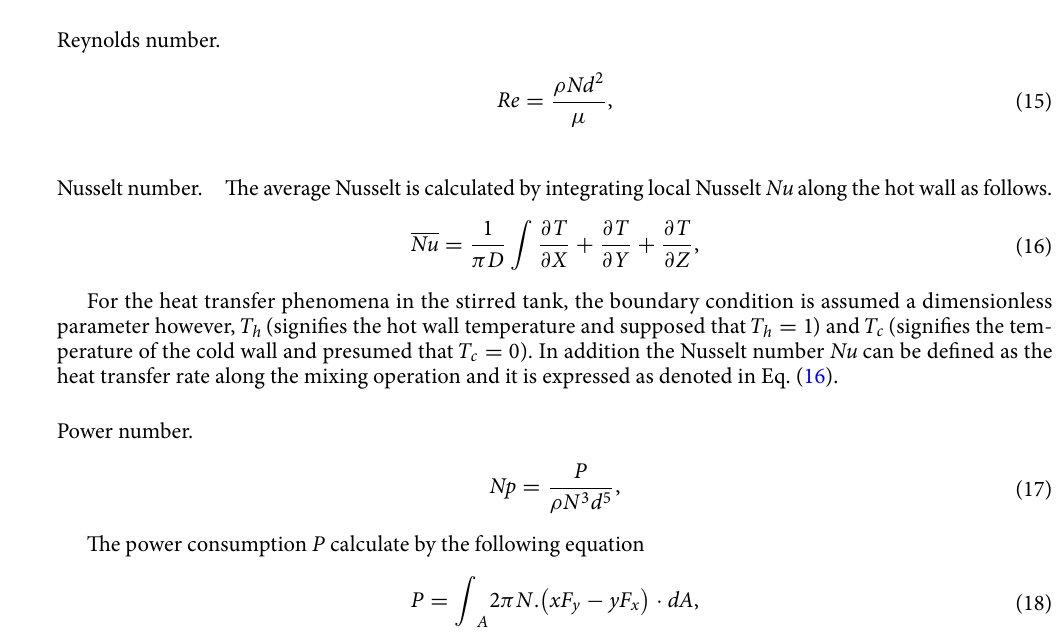
Figure 4. Validation curves for ( a ) power number and ( b ) tangential